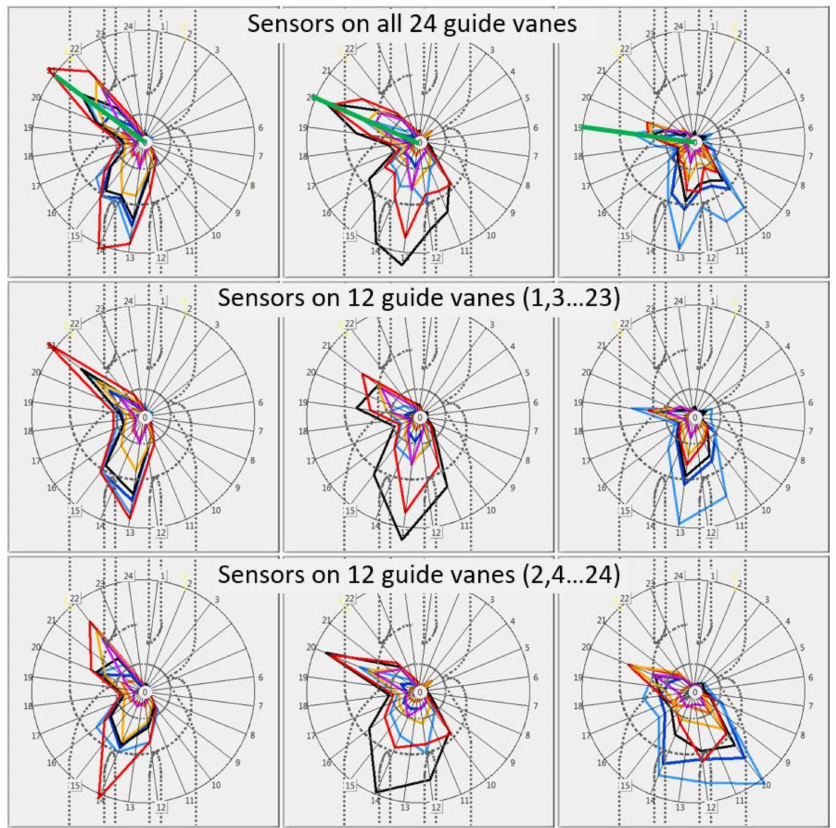
Figure 16. The analysis as in Figure 15 made for several